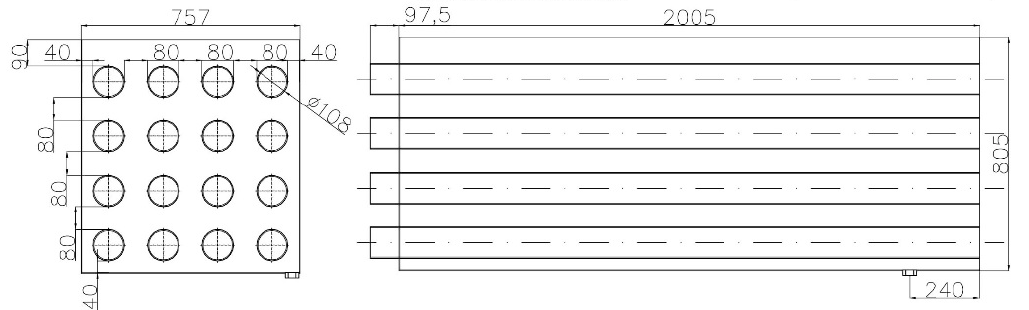
Figure 1. Cross-section of the PCM battery.